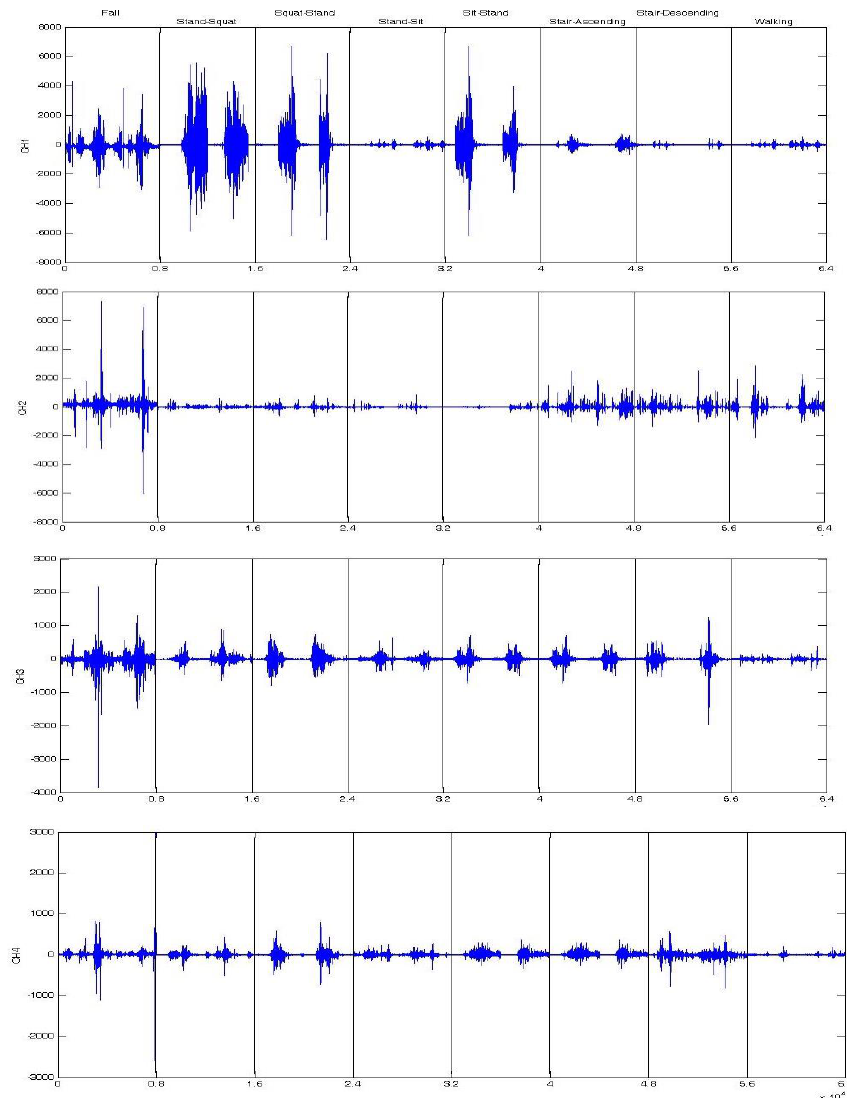
Figure 3. Examples of raw sEMG signals of some typical activities.